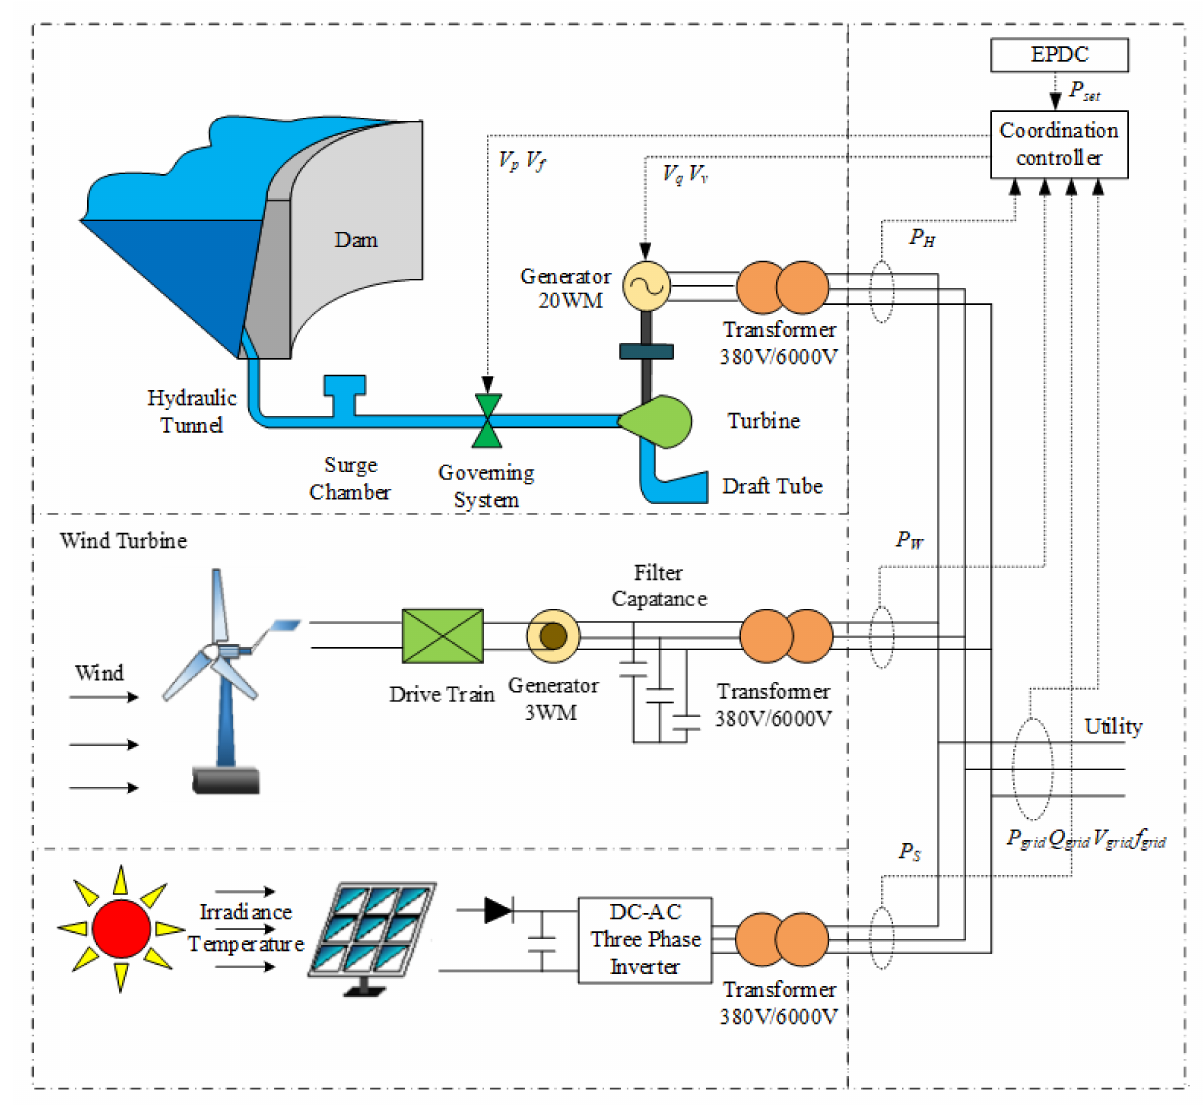
Figure 1. Schematic diagram of wind/solar/hydropower integrated system. Images of wind turbine, PV generator, and electric load from the ref.